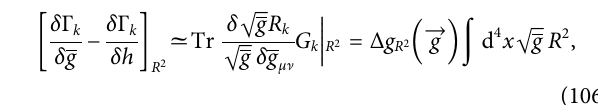
Frontiers in Physics |